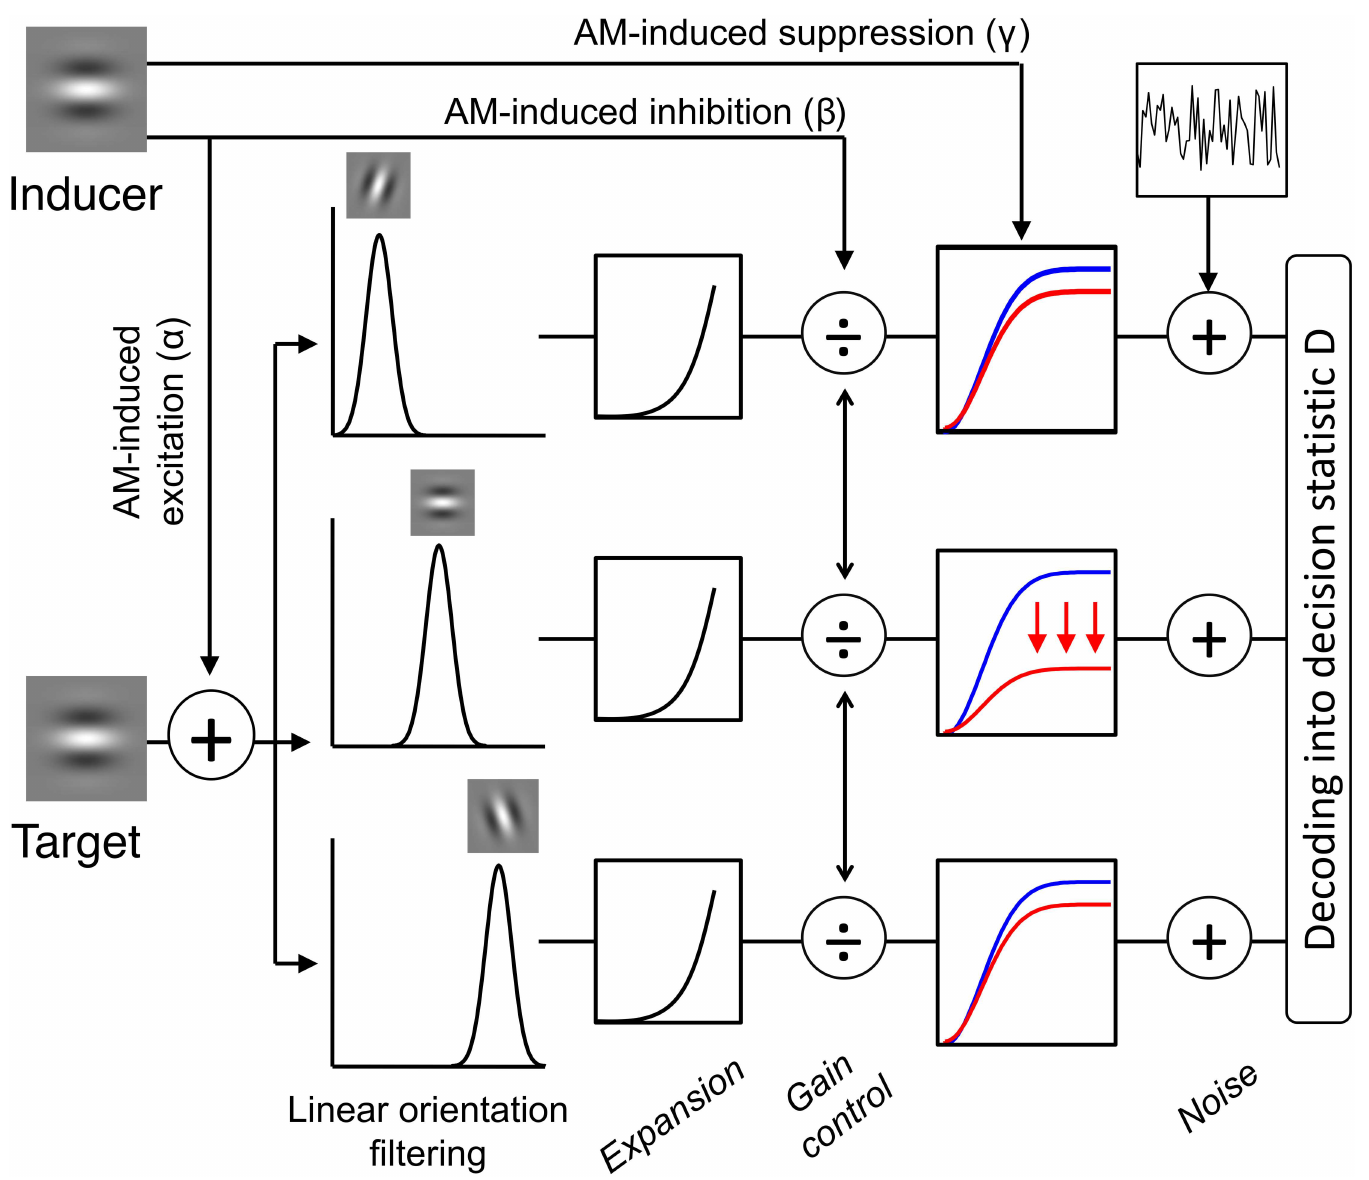
Fig 4. Schematic overview of possible AM-induced effects in the contrast normalization model. Followingthe standard contrast normalization model, the target grating in our task is encoded by a population of V1-like neuronstuned to orientation, which are subject to response acceleration and divisive inhibition.This standard model is extended by includingthe effects of AM, which can modify the encodingof gratings in our model in three ways. (1) AM can excite linear receptive fields sensitive to the orientation of the inducers controlledby α , evoking responsesas if the inducer was physicallypresent at the target location (as during real motion). This would correspondto a “filling-in”process along the AM path. (2) AM can induce divisive normalization via β by exciting neurons in the gain control pool tuned to the orientationof the inducers. A similar divisive normalization signal would be observed when the inducer would be positionedat the target location. As such, AM-inducedinhibitionis also in accordance with a “filling-in” account of AM. (3) AM can scale down the contrast response functions due to the suppressiveeffect exerted by neuronstuned to the inducers’ orientationvia γ